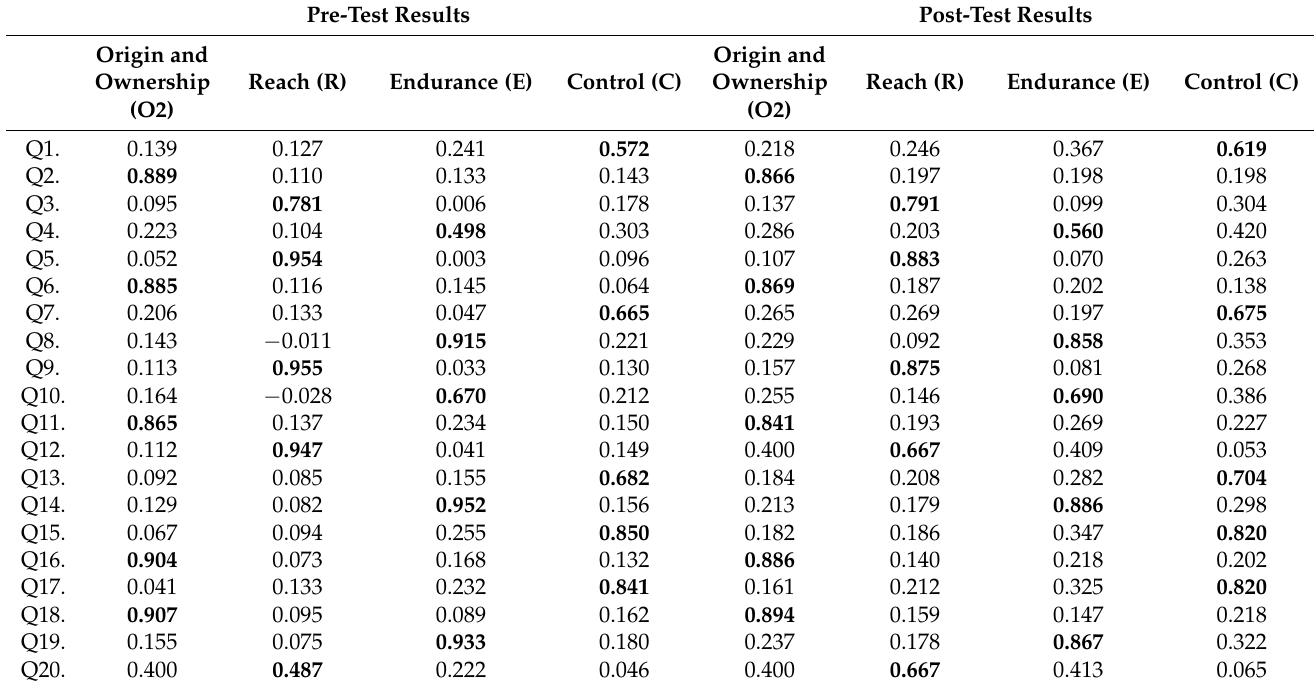
Table 4. Results of Exploratory Factor Analysis of items on the Adversity Response Profile (N = 272). Pre-Test